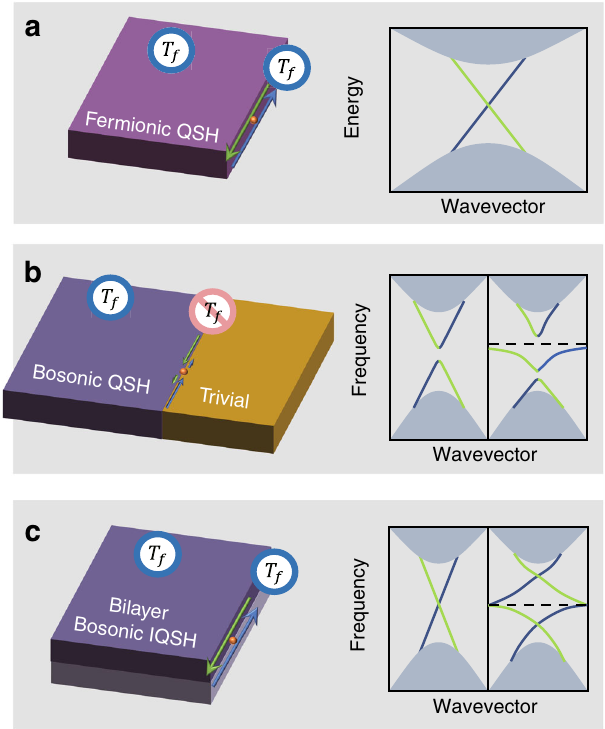
Fig. 1 | QSH in fermionic and bosonic systems. a Fermionic QSH case and its gaplesshelicaledgestateswith T f maintainedforboththebulkandboundary. b 2D (single-layer)bosonicQSHcasewithatrivialcladdingcrystal.Thereisagapforthe edgedispersionbecauseoftheabsenceof T f .Aresonatorontheboundaryscatters different helical states and further breaks its dispersion. c Bilayer bosonic IQSH case. It allows robust helical edge states without cladding crystals, which is robust against a resonator.